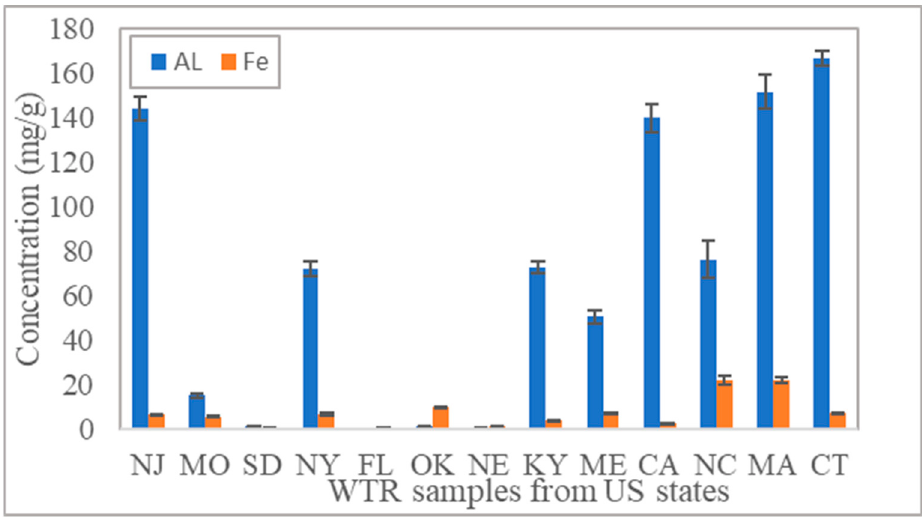
Figure 1. Oxalate-extractable Al and